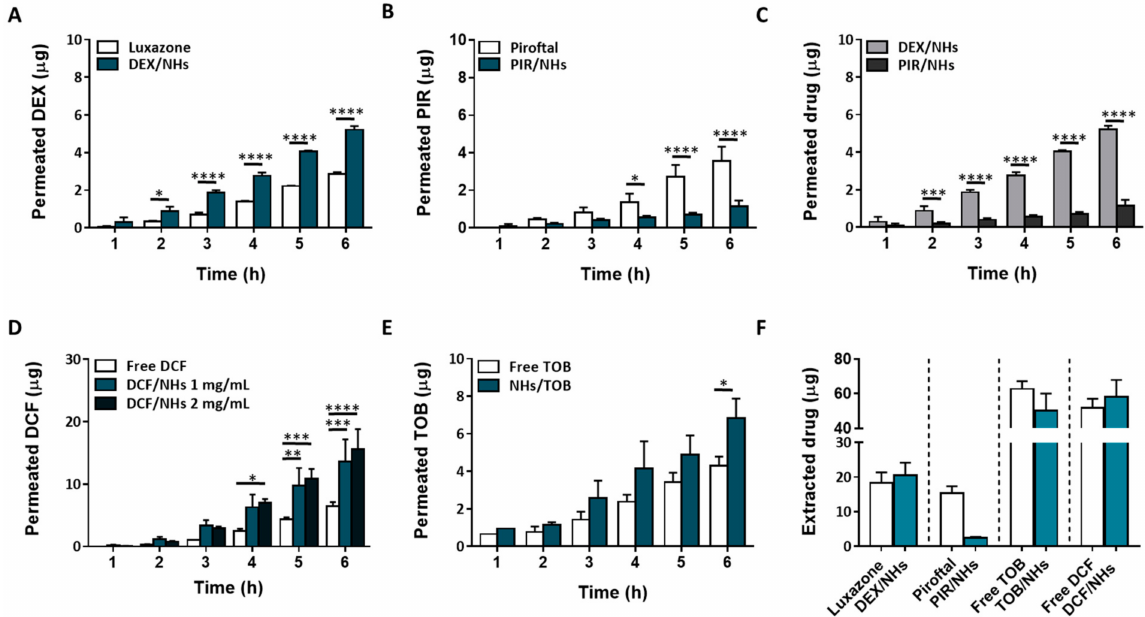
Figure 5. Ex vivo transcorneal permeation profiles for DEX/NHs and Luxazone ( A ), PIR/NHs and Piroftal ( B ), TOB/NHs and free TOB solution ( C ) and DCF/NHs and free DCF solution ( D ). Comparison of transcorneal permeation profiles of DEX/NHs and PIR/NHs ( E ). Corneal retention values of DEX, PIR, TOB and DCF comparing drug-loaded NHs and free drug solutions after 24 h of exposure ( F ). Asterisks denote statistically significant differences. The one-way analysis of variance (ANOVA) was carried out followed by Tukey’s multiple comparisons, and statistically significant differences were identified when p -values were lower than 0.05 (* p < 0.05), 0.01 (** p < 0.01), 0.001 (*** p < 0.001) and 0.0001 (**** p <